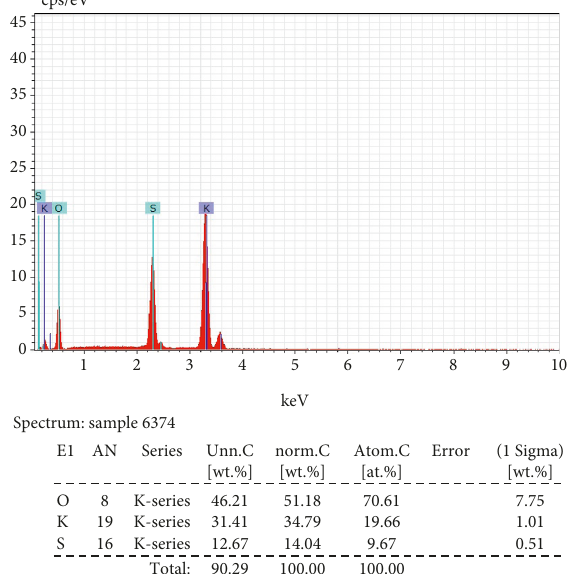
Figure 6: TEM image of the methyl orange dye-doped K single crystal. 2 SO 4 single crystal.